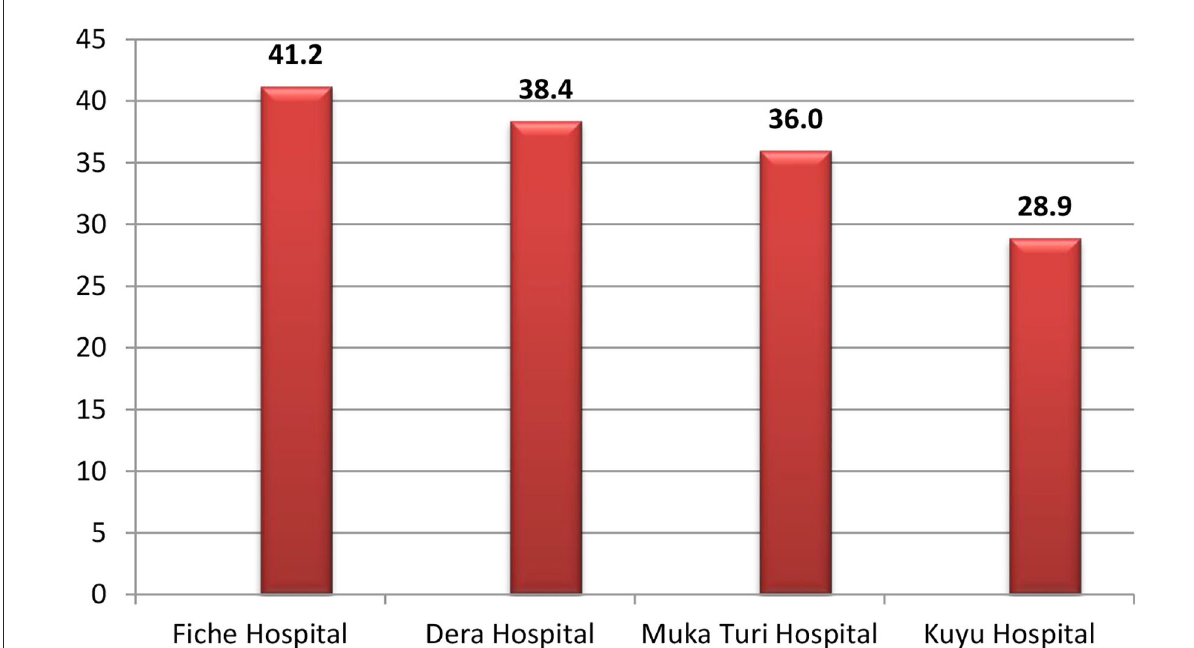
FIGURE3 Percentage distribution of near-miss cases among newborns delivered in each public health hospital of North Shewa zone, Central Ethiopia,